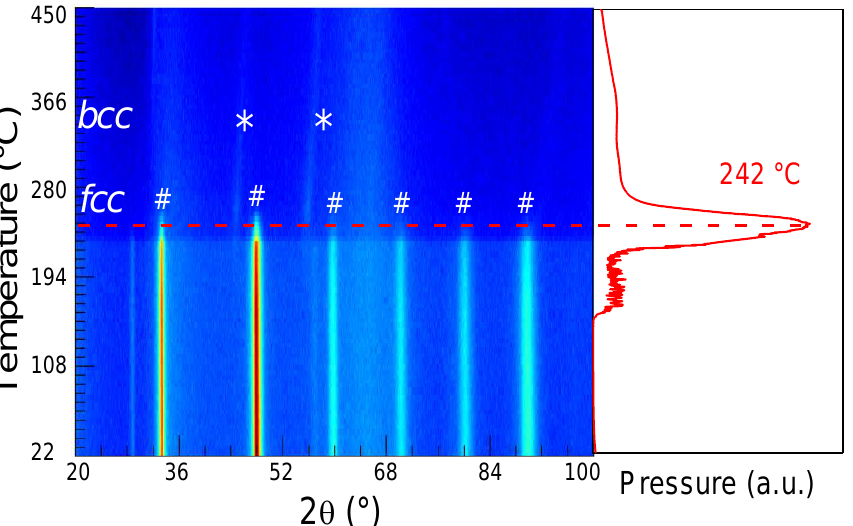
Figure 7. In situ neutron diffraction (λ = 1.2858 Å) of Ti 0.30 V 0.25 Zr 0.10 Nb 0.25 Mo 0.10 D 2 with a heating rate of 1 °C/min under dynamic vacuum ( left ). The desorption profile during neutron diffraction ( right ). The initial fcc deuteride and the final bcc desorbed phases are marked with # and *, respectively. The deuterium desorption from the Ti 0.30 V 0.25 Zr 0.10 Nb 0.25 Mo 0.10 D 2 occurs within three